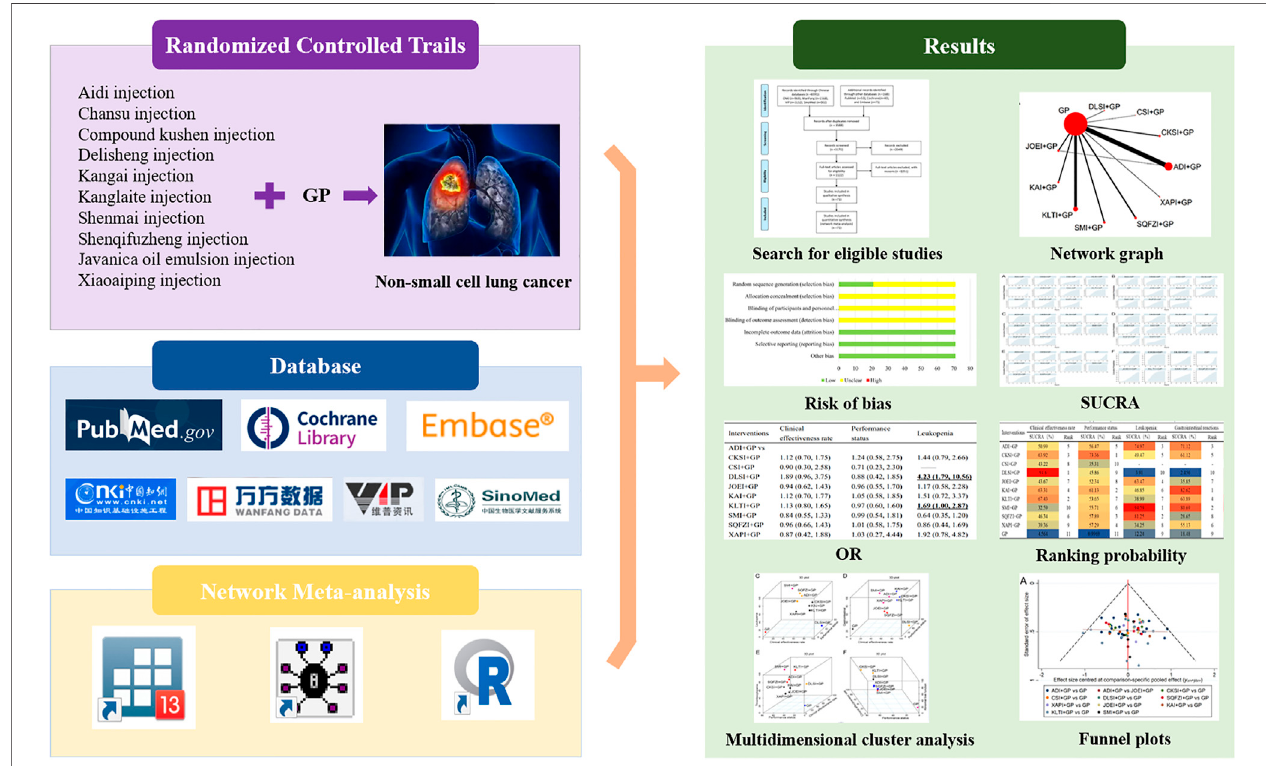
FIGURE 1 | Graphical abstract of the network meta-analysis. Note: GP, gemcitabine plus cisplatin; SUCRA, surface under the cumulative ranking curve; OR, odds ratio.